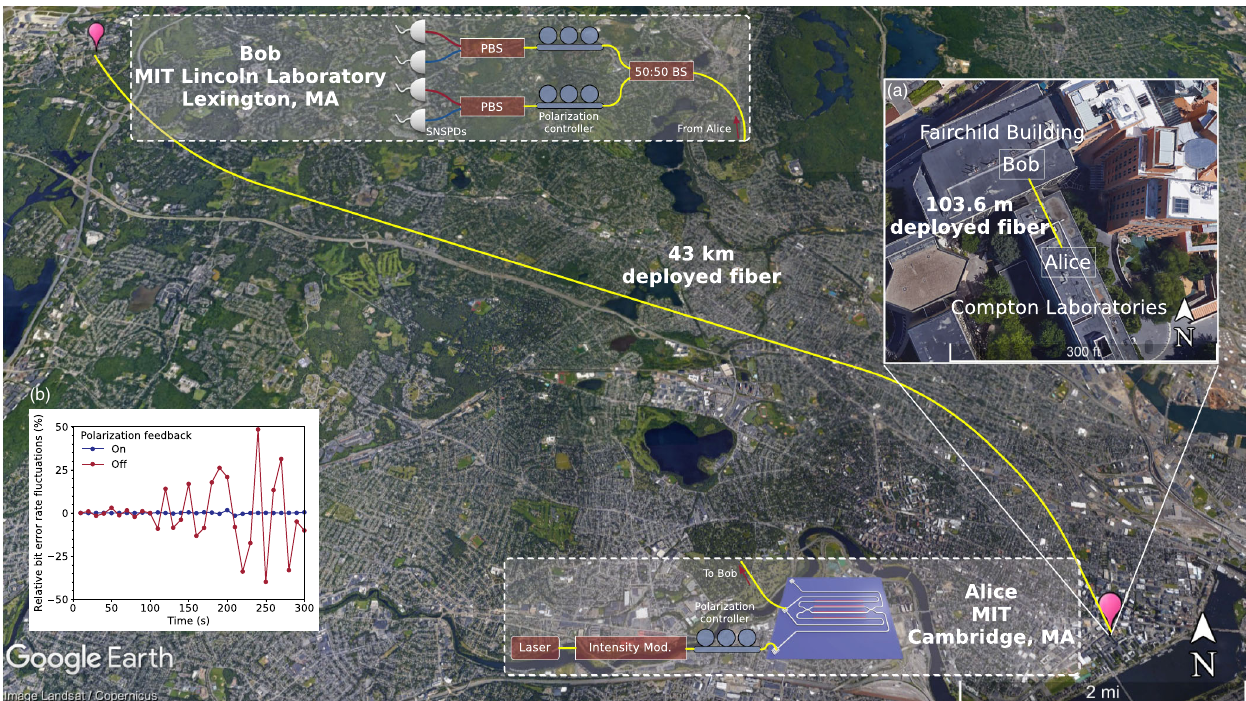
FIG. 2. Aerial view of the intercity QKD field test. Alice is located at Massachusetts Institute of Technology (MIT) in Cambridge and Bob is located at MIT Lincoln Laboratory in Lexington. Although the point-to-point distance between the two stations is ∼ 18 km, they are connected by a 43-km dark fiber link. Alice consists of an attenuated laser source, an intensity modulator, and the silicon photonics polarization encoder. Bob consists of two polarizing beam splitters (PBSs) followed by four superconducting nanowire single-photon detectors (SNSPDs). Insets: (a) Close-up aerial view of the local QKD field test, where Alice and Bob are located in two adjacent MIT buildings connected by a 103.6-m deployed dark fiber link. Alice ’ s and Bob ’ s setups are the same as the ones used in the intercity test. (b) Fluctuations on the bit error rate with and without polarization feedback control, relative to the starting bit error rate. Imagery ©2017 Google. Map data from Google,